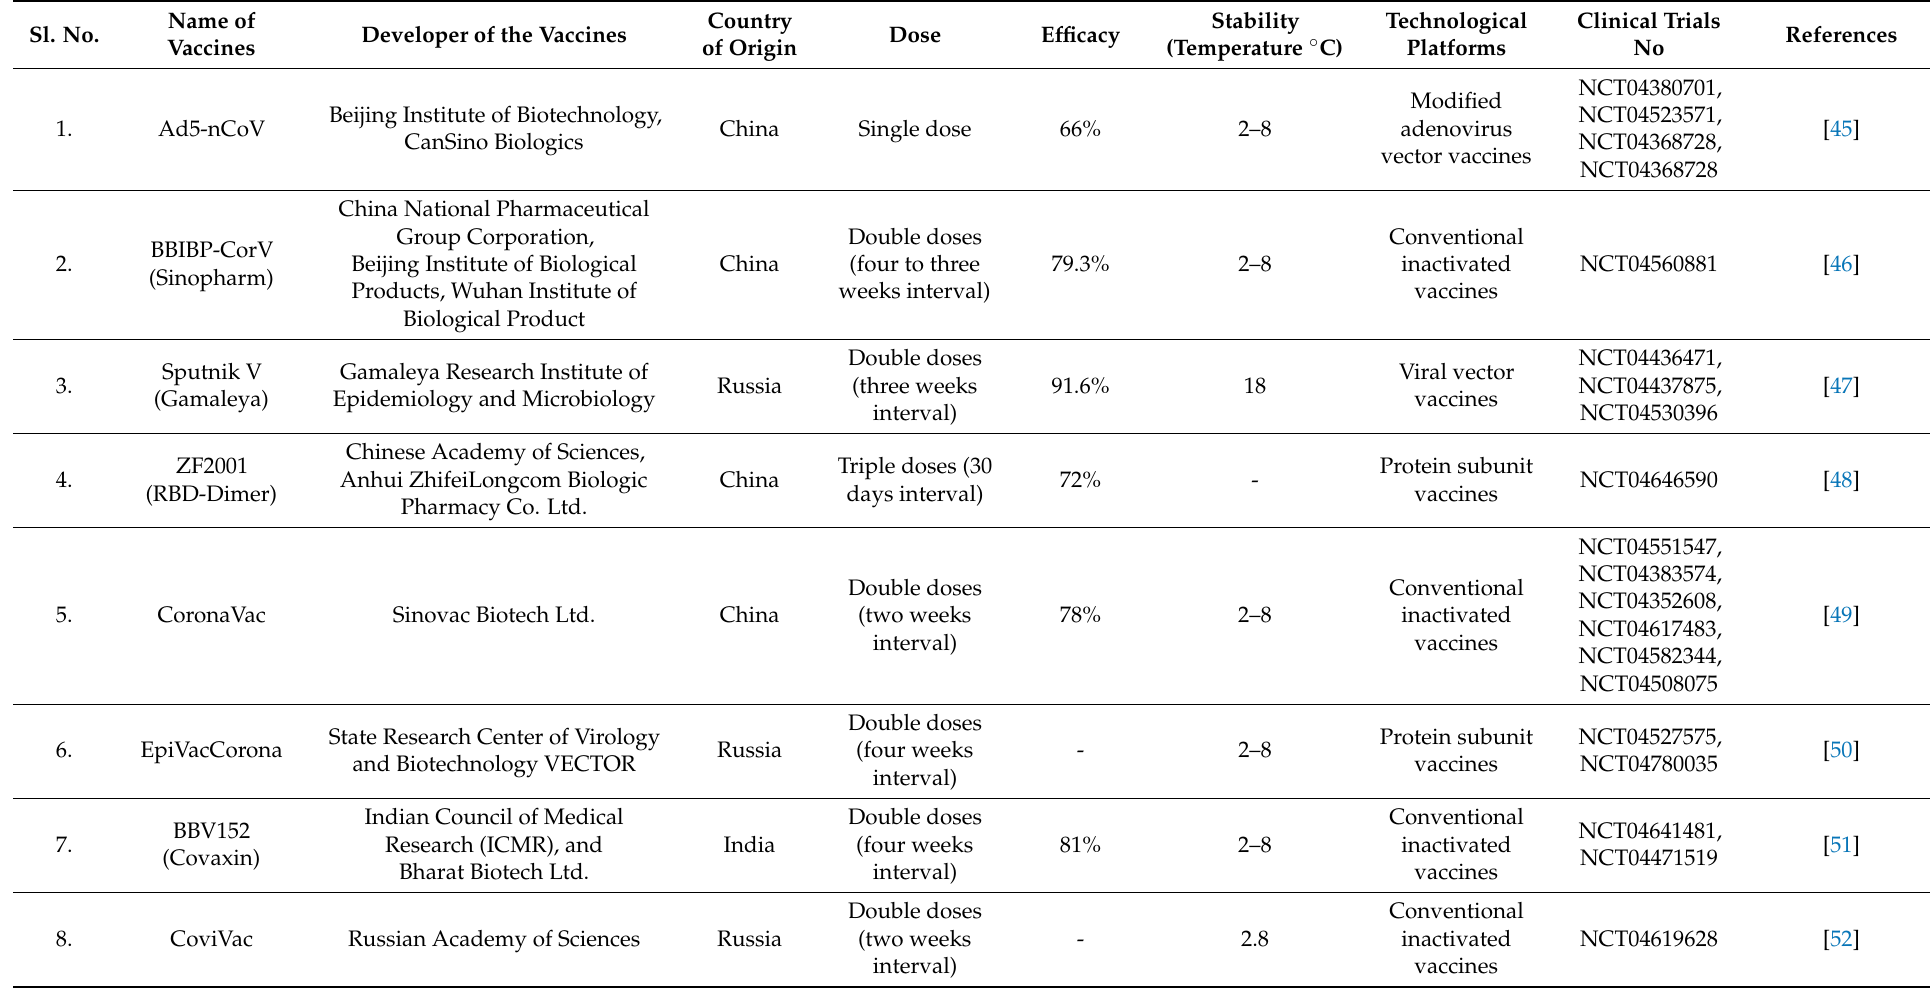
Table 1. Approved Asian-origin COVID-19 vaccines and their developers, dose, efficacy, stability, technological platforms, and clinical trials number. Sl.